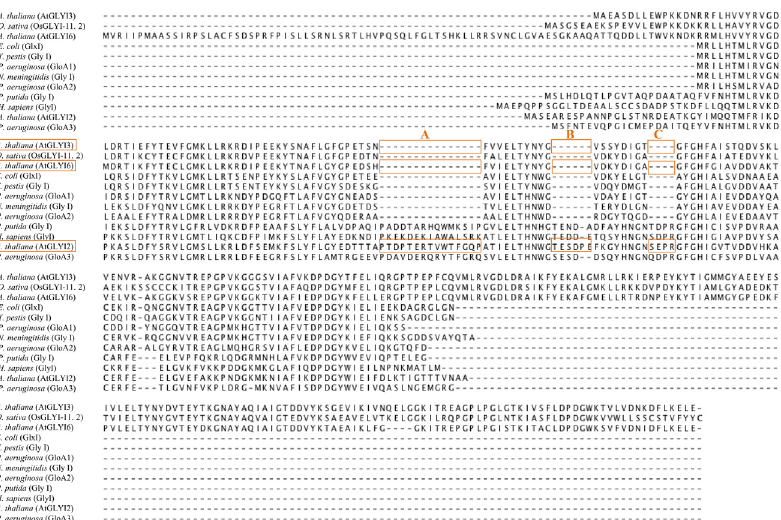
Fig 1. Sequence alignment of AtGLYI proteins with GLYI proteins from different species. Protein sequences of AtGLYI2, AtGLYI3 and AtGLYI6 (Acc. No. NP_172291.1, NP_172648.1, NP_176896.1 respectively) were aligned with GLYI protein sequences from O . sativa (Os08g09250), E . coli (AAC27133), Y . pestis (YP_002347347), P . aeruginosa (GloA1, GloA2 and GloA3 with Acc. No. AAG06912, AAG04099 and AAG08496 respectively), N . meningitidis (NP_273389.1), H . sapiens (NP_006699) and P . putida (NP_745896). The letters A, B and C represent extended sequences found in Zn 2+ dependent GLYI and absent in non-Zn 2+ dependent